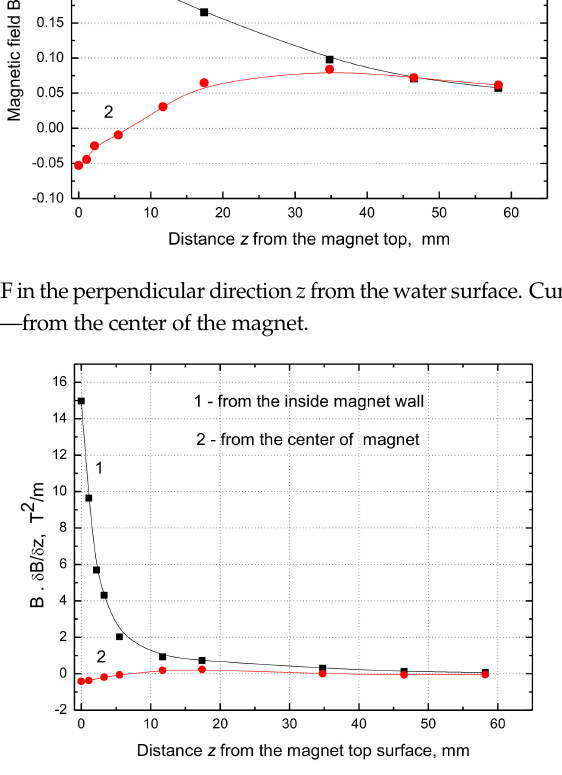
Figure 9. The product of magnetic field and its gradient along the direction z perpendicular to the water surface from the top of inner magnet wall (curve 1) and from the magnet center (curve